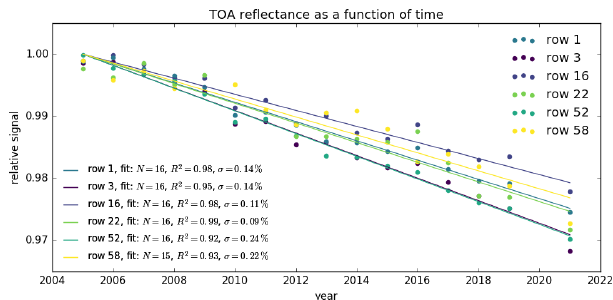
Figure 9. Changes in 340nm TOA reflectance with time at several OMI rows over Antarctic ice surfaces. The dots show monthly aver- ages for January, which were used to derive radiance corrections for each row individually using a linear regression model (lines). The standard deviations σ which are reported are for the fitting residu- als.